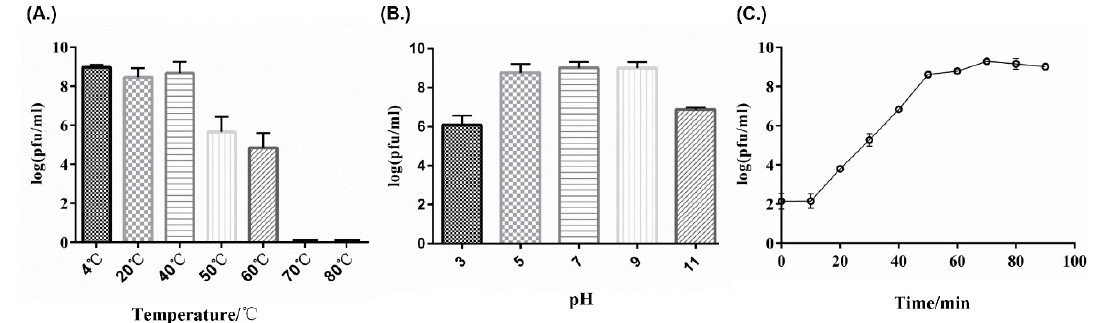
Figure 3. Biological properties of phage PHB01. ( A ) Sensitivity to temperature variations; ( B ) Sensitivity to pH variations; ( C ) One-step growth curve.